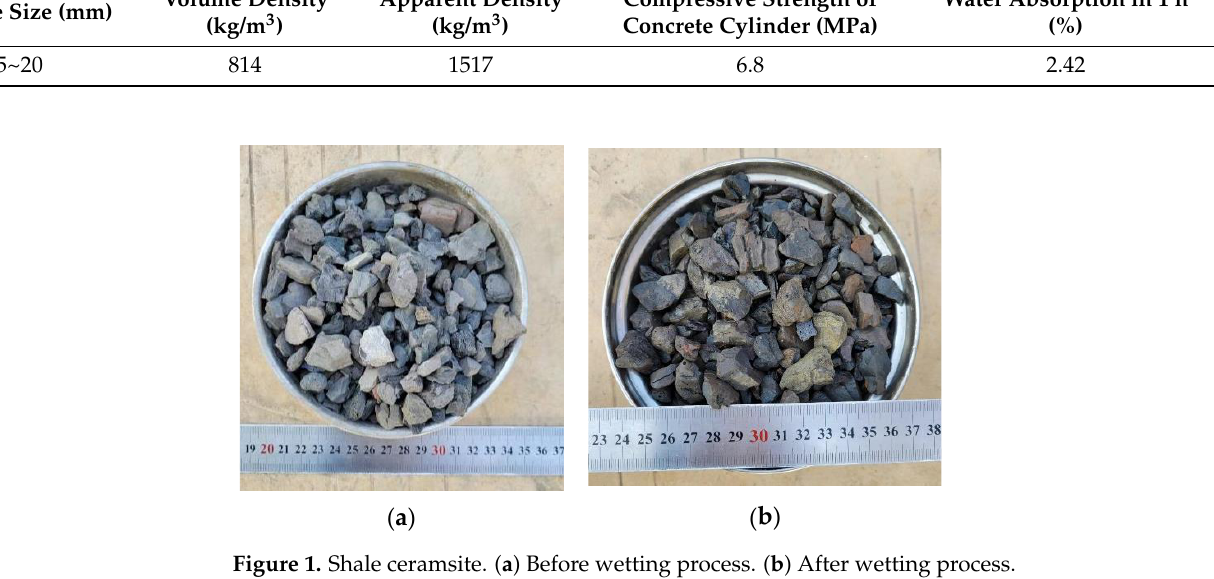
Table 1. Physical properties of shale ceramsite.